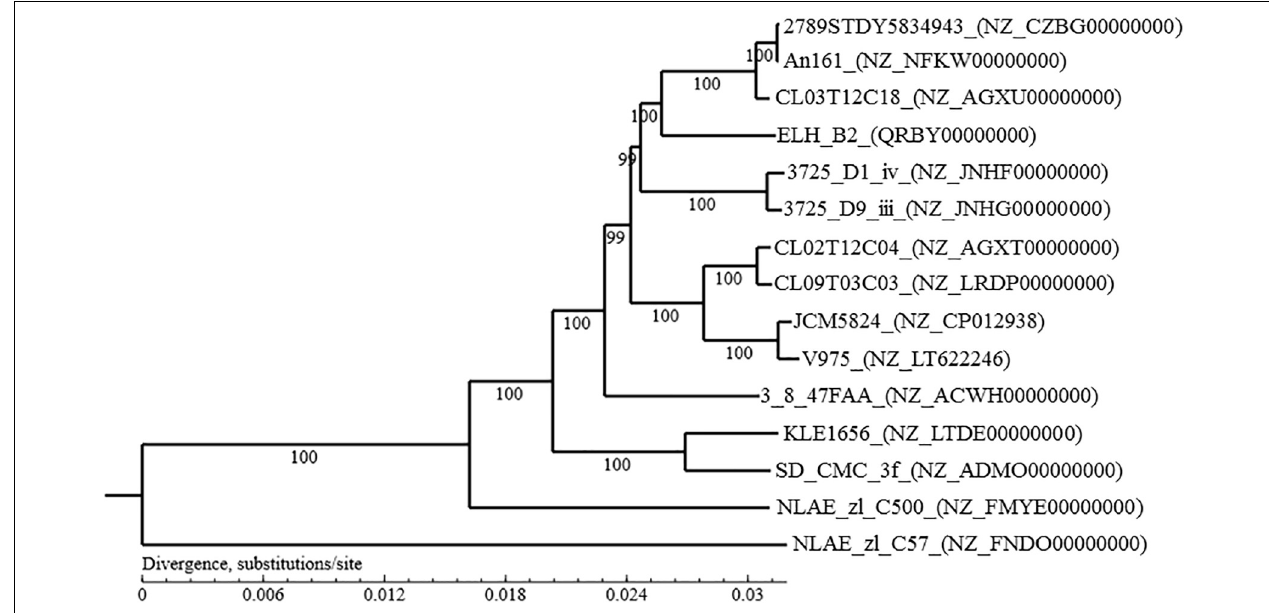
FIGURE 1 | Phylogenetic tree based on the complete genome sequences of Bacteroides ovatus ELH-B2 and other B. ovatus